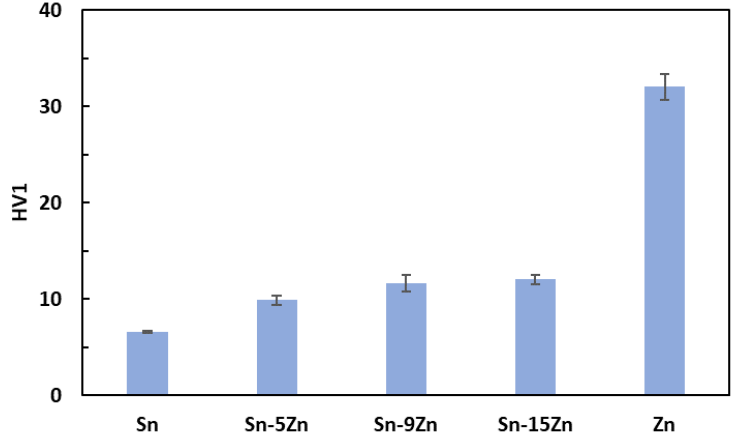
Figure 3. Vickers hardness of the Sn – xZn alloys.